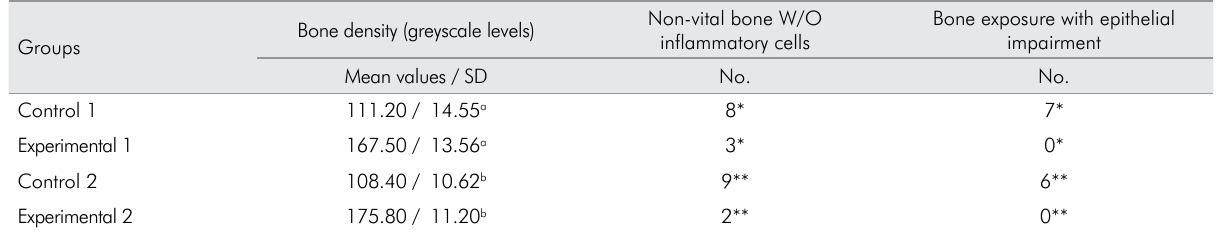
Non-vital bone W/O Bone exposure with epithelial inflammatory cells impairment